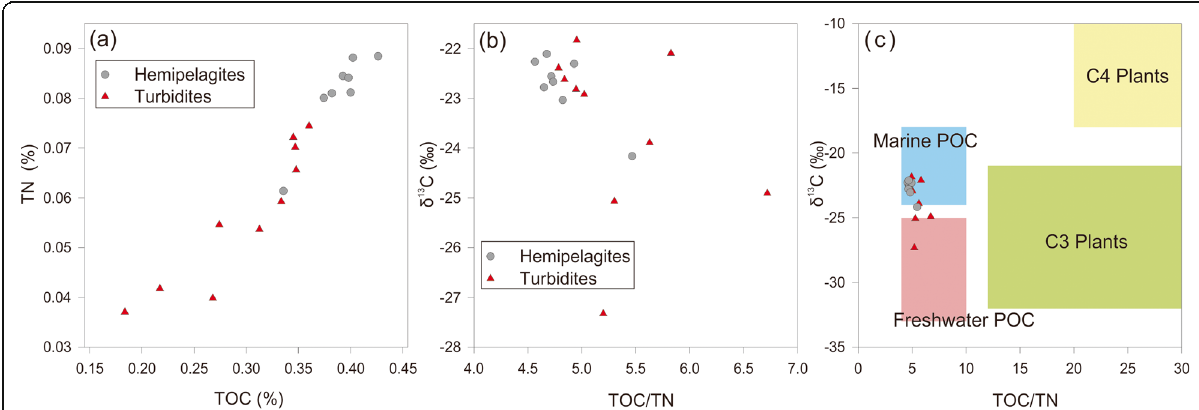
Fig. 10 Organic geochemistry results from hemipelagites (gray dots) and turbidites (red triangles) are grouped based on their stable carbon isotopic compositions ( δ 13 C) and total organic carbon (TOC) and nitrogen (TN) contents. a TN vs. TOC, b δ 13 C vs. TOC/TN, and c δ 13 C vs. TOC/TN shown at a broader scale and interpreted in terms of particulate organic carbon (POC) provenance after Lamb et al. (2006). C3 and C4 plants represent the fields of terrestrial